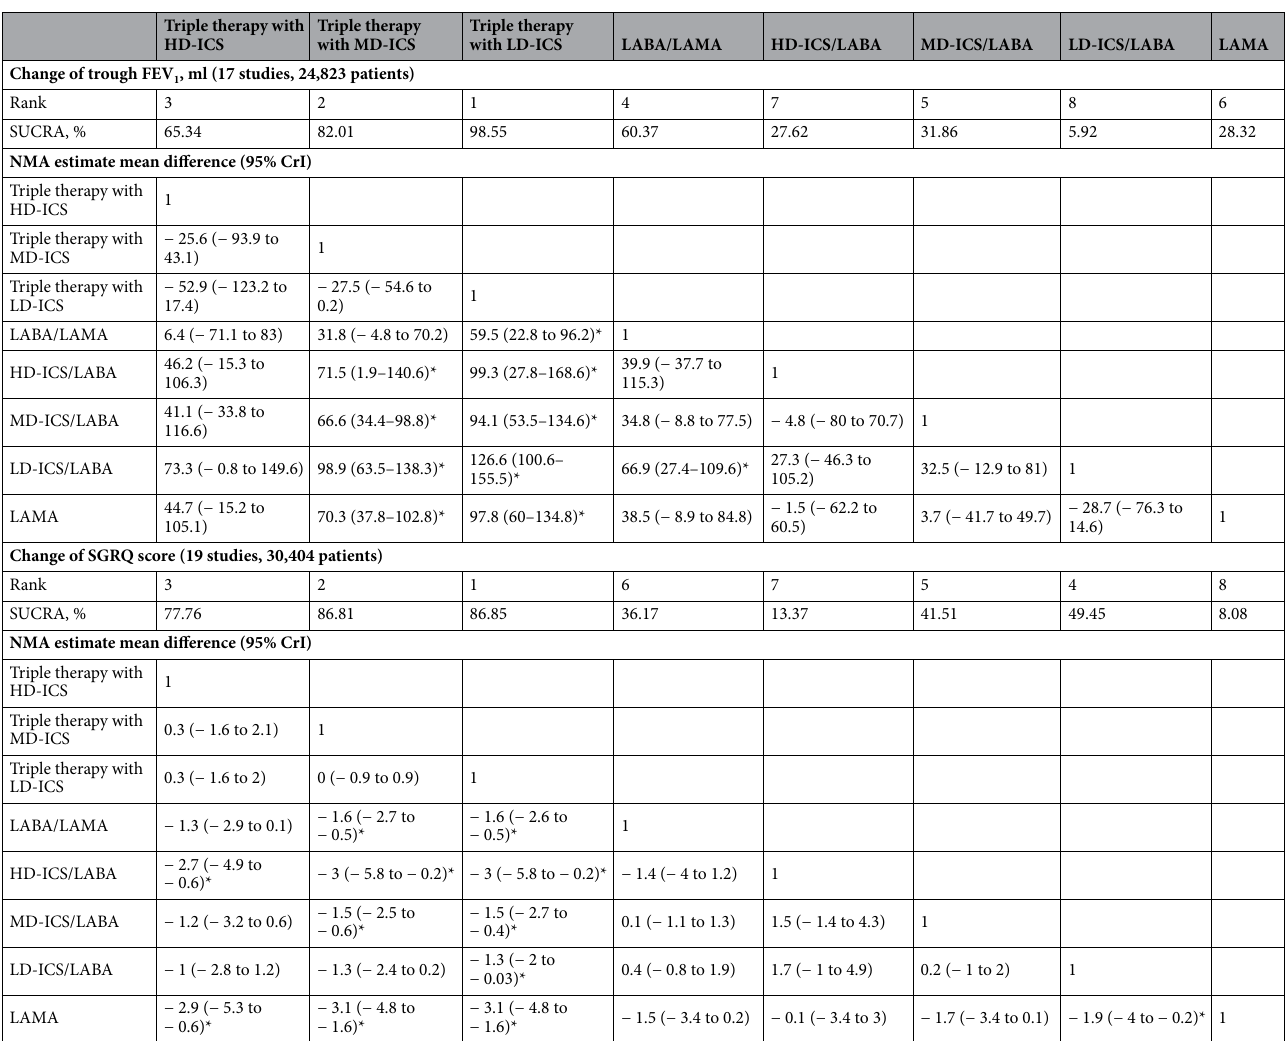
Table 3. Change in trough FEV 1 or SGRQ score with different inhaled therapies. CrI: credible interval; FEV 1 : forced expiratory volume in one second; HD: high-dose; ICS: inhaled corticosteroid; LABA: long-acting beta-agonist; LAMA: long-acting muscarinic antagonist; LD: low-dose; MD: medium-dose; NMA: network meta-analysis; SGRQ: St. George’s respiratory questionnaire; SUCRA: surface under the cumulative ranking curve. Mean difference with 95% CrI was calculated by subtracting row (left) from column (upper). If the mean difference is significantly lower than 0, the drug in the left row is considered to be more beneficial than the other drug in the upper column. *Indicates that the posterior probability is either less than 0.025 or more than 0.975, which is considered statistically